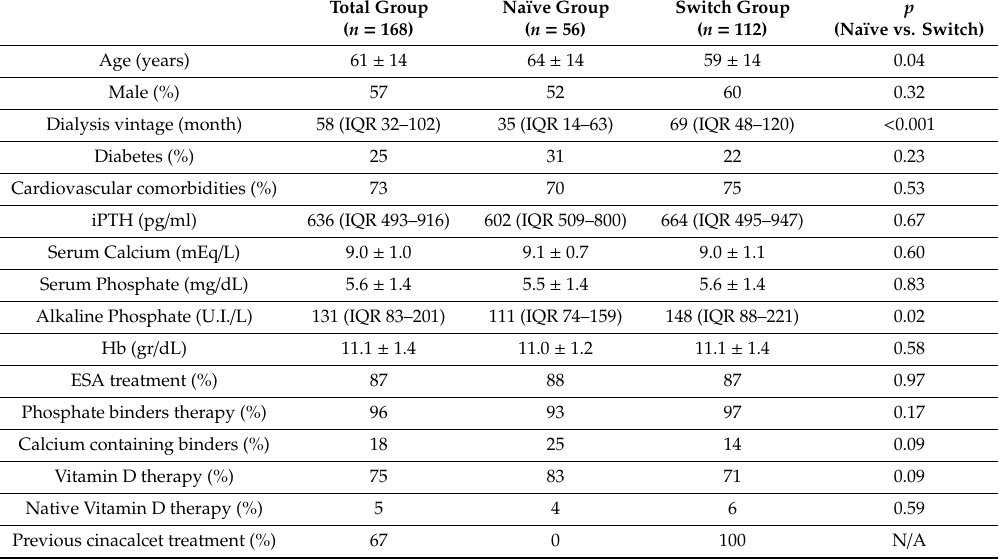
Table 1. Patients’